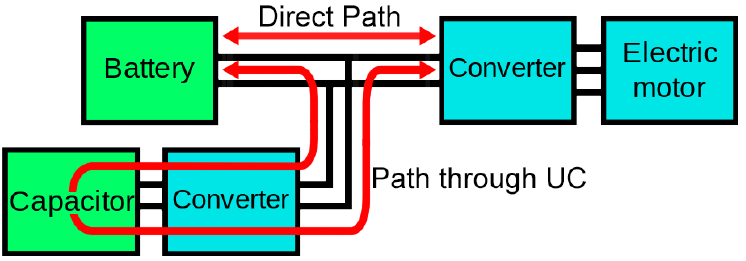
Figure 5. HESS power paths. Power on the direct path between battery and motor experiences minimal losses, while power on the path through the UC experience additional losses from the UC internal